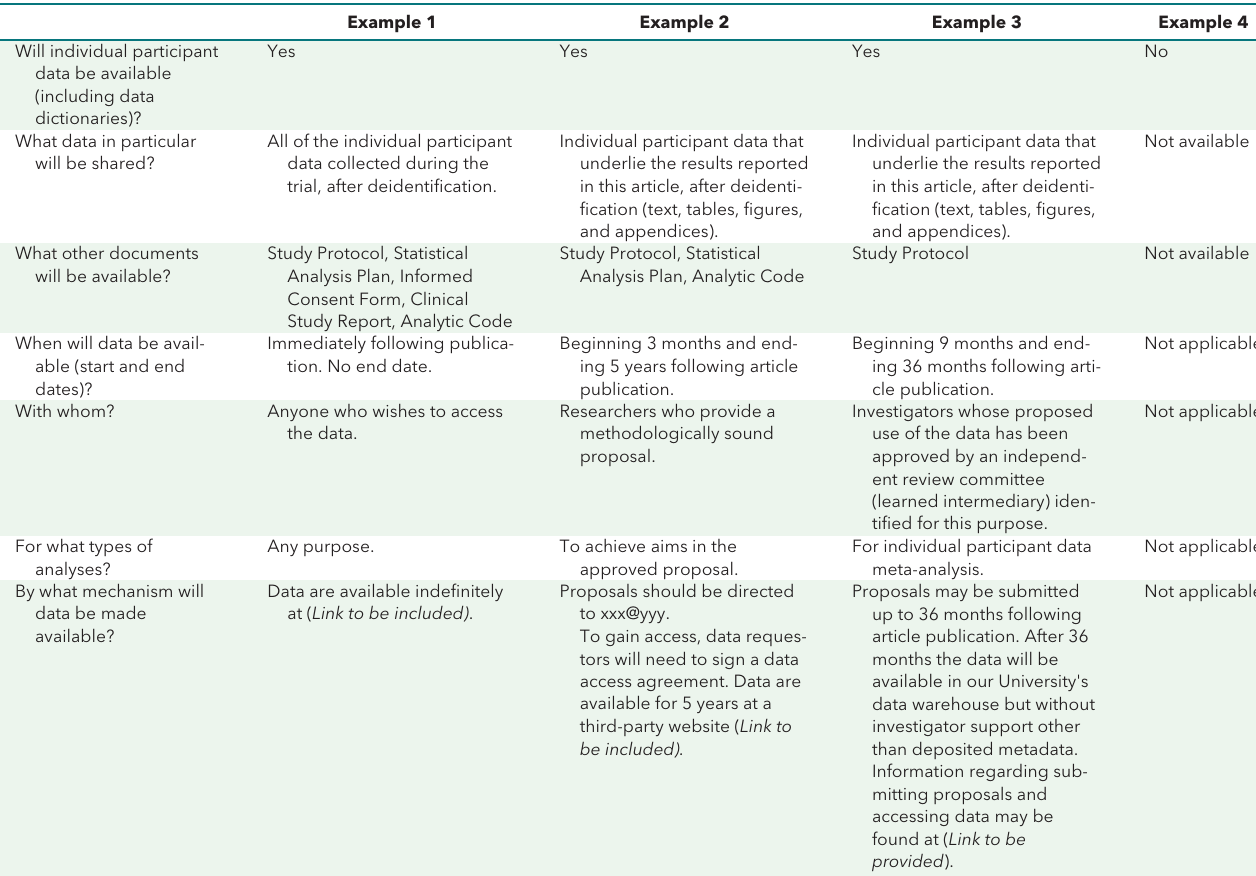
Table 1. Examples of Data Sharing Statements That Ful fi ll These ICMJE Requirements